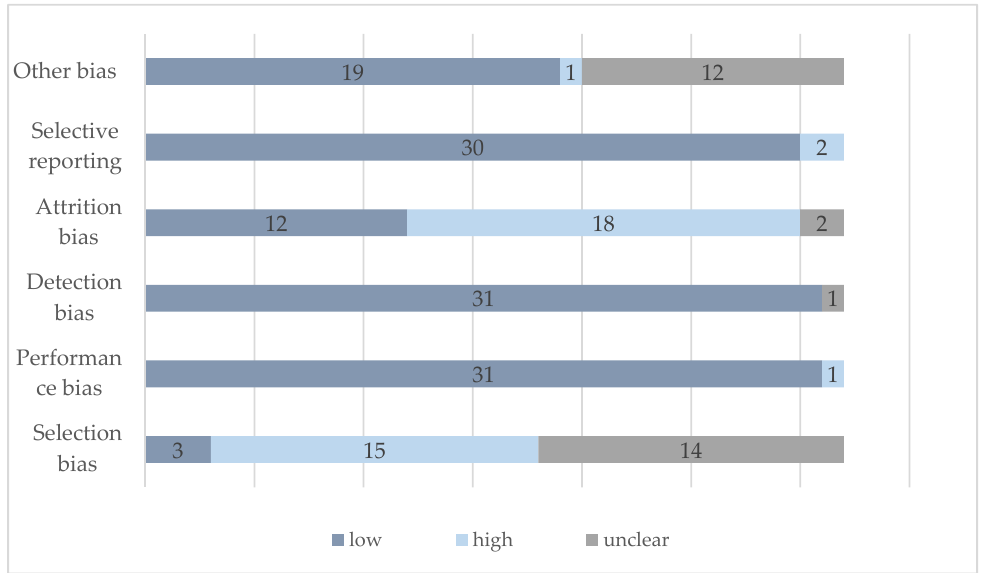
Figure 2. Risk of bias of included studies.